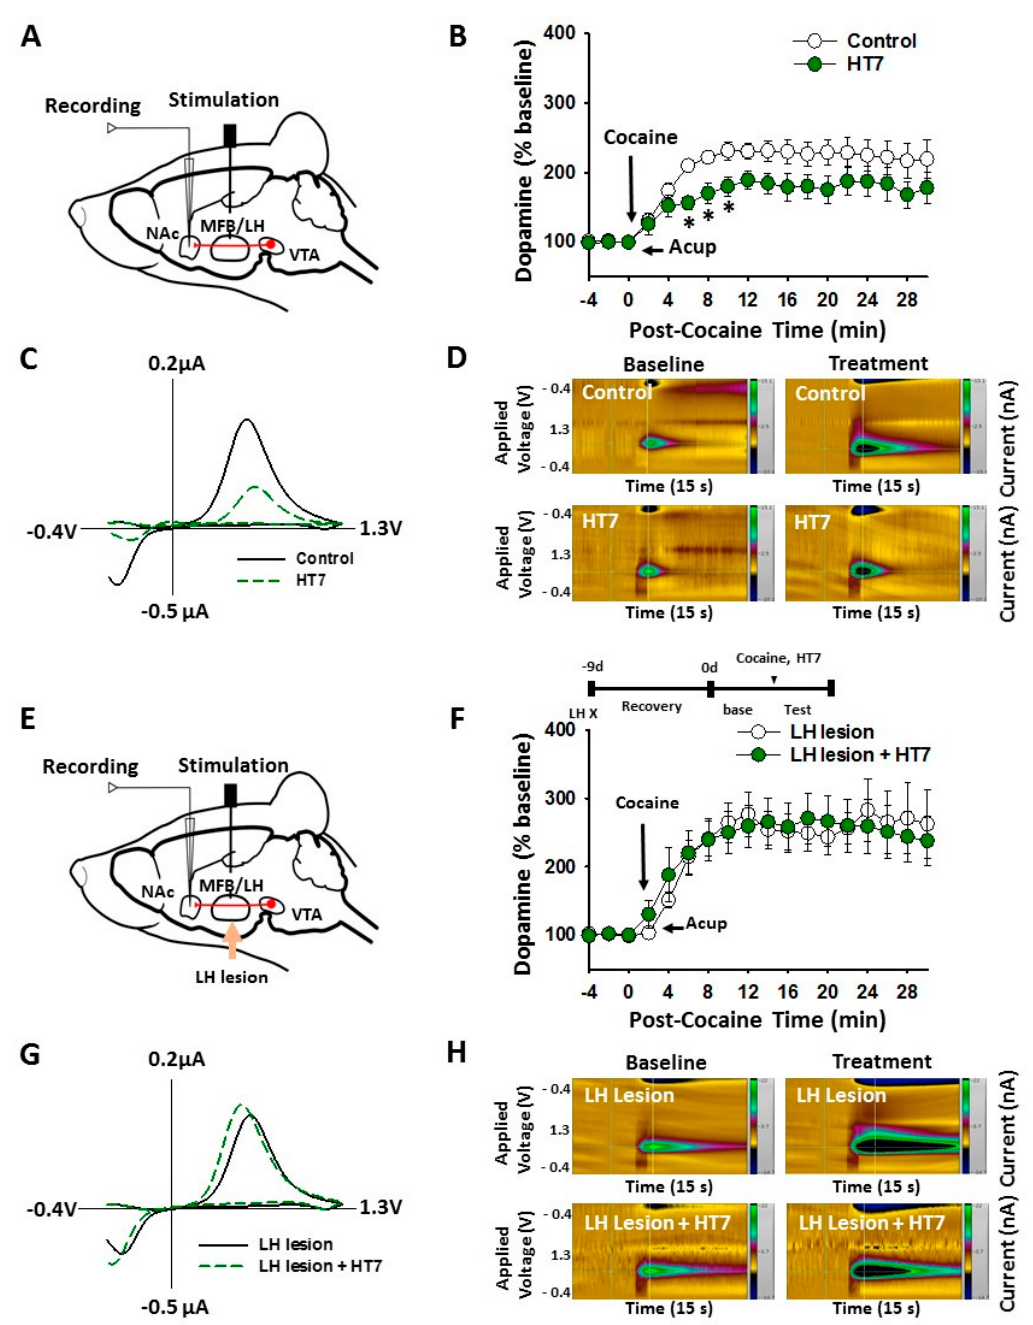
Figure 3. Mediation of the LH in acupuncture inhibition of cocaine-induced DA release in NAc. ( A – D ) Effect of acupuncture at HT7 on cocaine-induced DA release in NAc in rats. * p < 0.05 vs. Control. Schematic of fast-scan cyclic voltammetry (FSCV) for the recording of NAc DA release ( A ). ( B ) shows electrically stimulated NAc DA release at the 2 min intervals for 30 min after cocaine injection (15 mg/kg). * p < 0.05 vs. Control. Control, cocaine injection only ( n = 9); HT7, acupuncture at HT7 in cocaine-treated rats ( n = 7). Representative voltammograms ( C ) and pseudo-color plots ( D ) show DA FSCV signals 10 min after administration of cocaine. ( E – H ) Effect of LH lesions on the acupuncture inhibition of cocaine-induced DA release in NAc in rats. Schematic of FSCV for the recording of NAc DA release in LH-lesioned rats ( E ). ( F ) shows electrically stimulated NAc DA release at the 2 min intervals for 30 min after cocaine injection. Representative voltammograms ( G ) and pseudo-color plots ( H ) show DA FSCV signals 10 min after administration of cocaine. LH lesion, cocaine injection in LH-lesioned rats ( n = 6); LH lesion + HT7, acupuncture at HT7 after cocaine injection in LH-lesioned rats ( n = 5). Acup, acupuncture.